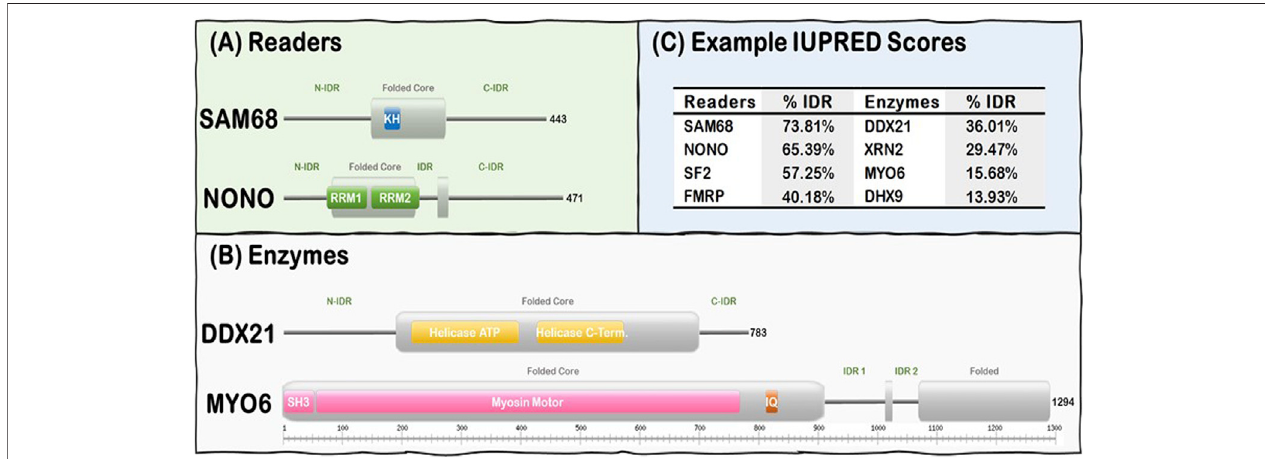
FIGURE 1 | R-loop interactome proteins are modular, containing both folded domains, and IDRs. (A) Examples of Readers containing KH domains (SAM68) and RRM domains (NONO). (B) Examples of Enzymes from the Helicase (DDX21) and the Hydrolase (MYO6) subgroups. Note Folded (gray rectangles) and IDRs (gray lines) are predicted from our IUPRED results while domain localization (e.g., KH, RRM, and SH3) was obtained from the UniProt database (UniProt: The universal protein knowledgebase in 2021, 2021). (C) Representative Readers and Enzymes with their IDR content (%).